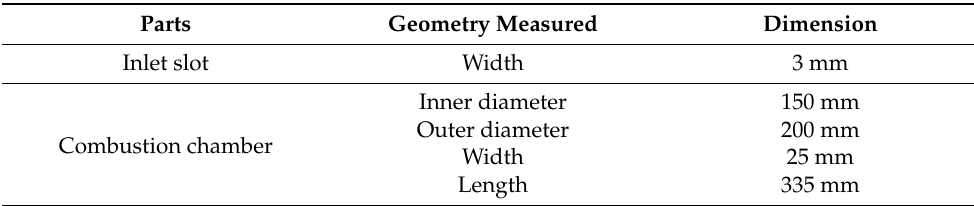
Table 1. RDE hardware dimensions.